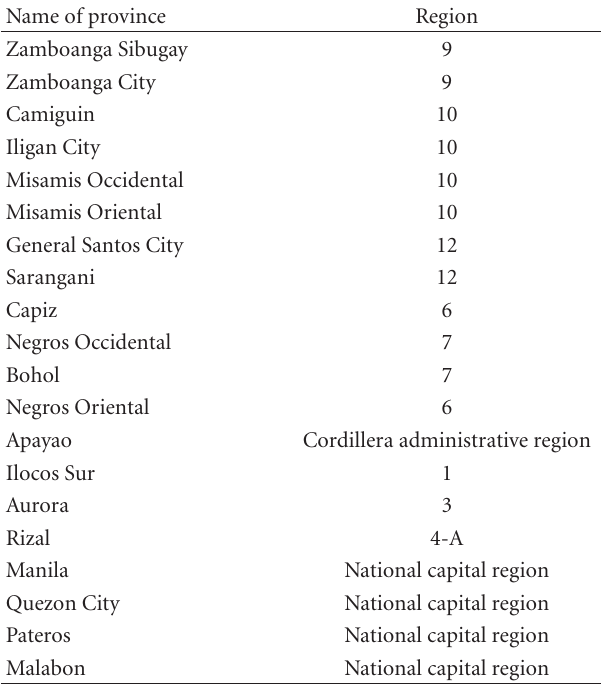
Table 4: List of other provinces and cities surveyed in